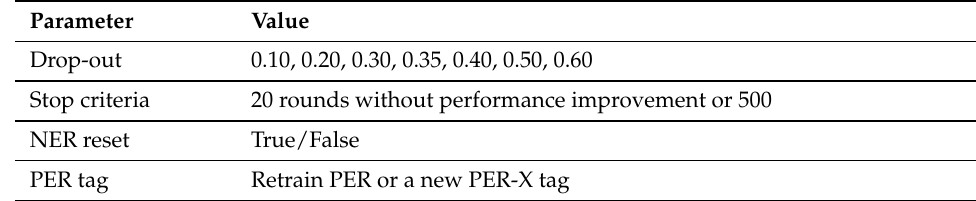
Table 1. Experiment parameters for NER training.